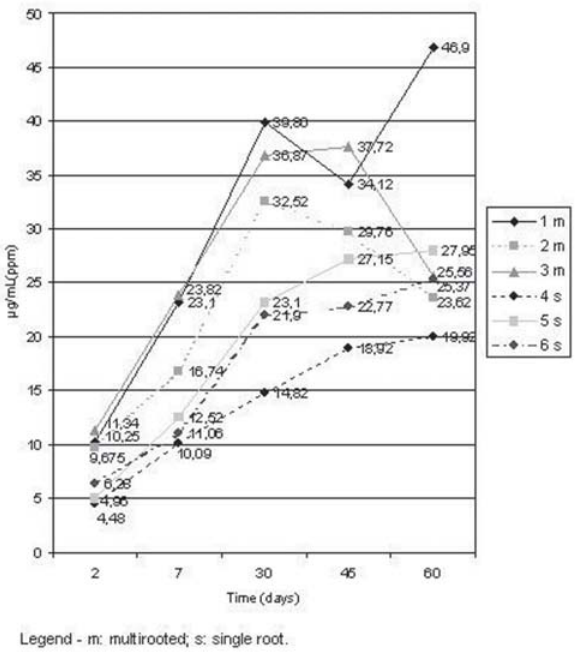
FIGURE 1- Calcium ion diffusion through test time (days) measure in µ g/mL (ppm) for control group